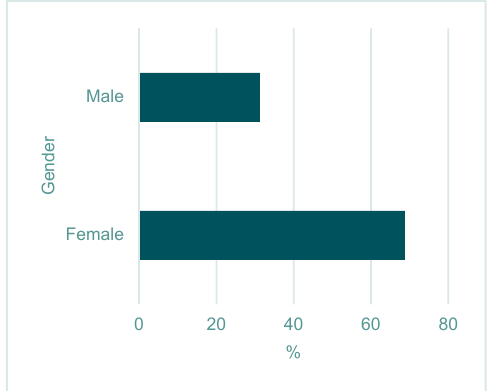
Figure 7. Number of responses by gender.